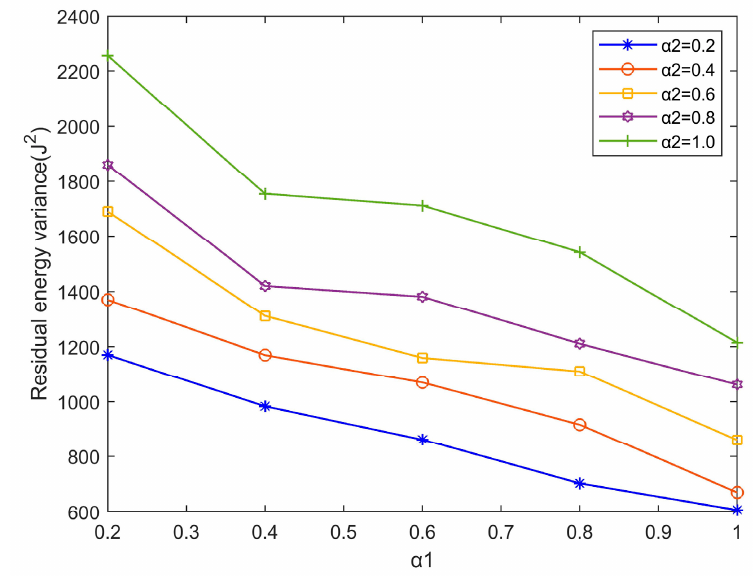
Figure 5. Residual energy variance of α 1 and α 2 (CR = 1500 m).